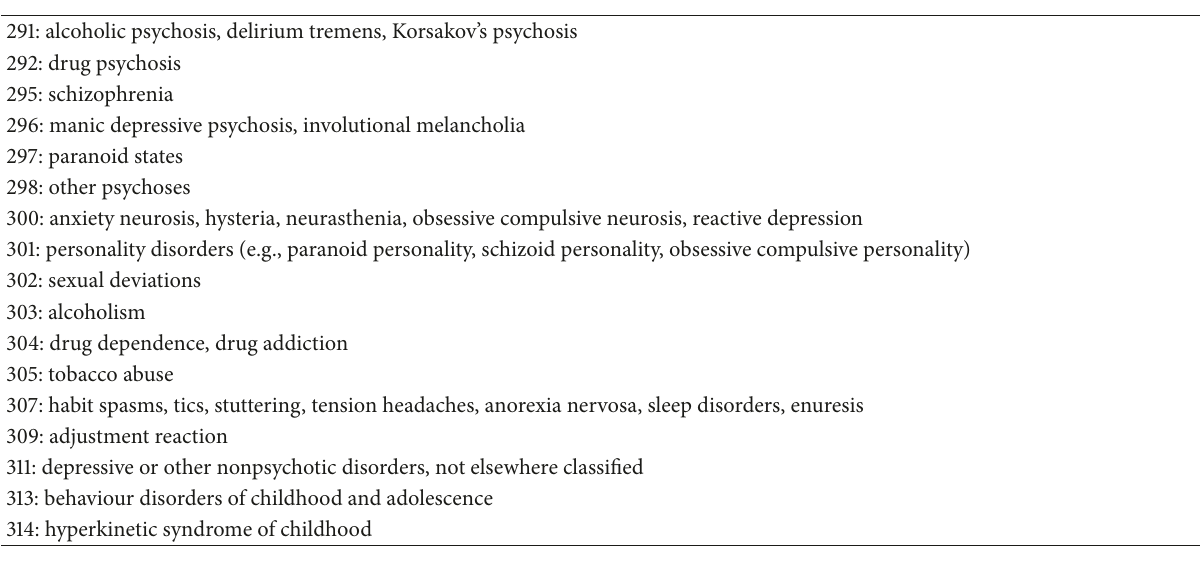
Table 1: ICD-9 mental health